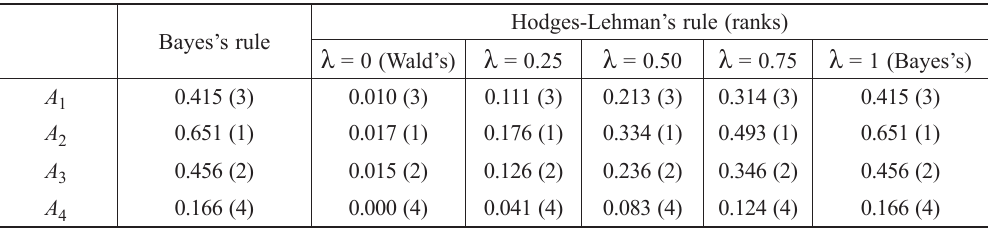
Table 8. Results of the Bayes’s and Hodges-Lehman’s rules Hodges-Lehman’s rule (ranks) Bayes’s rule λ = 0